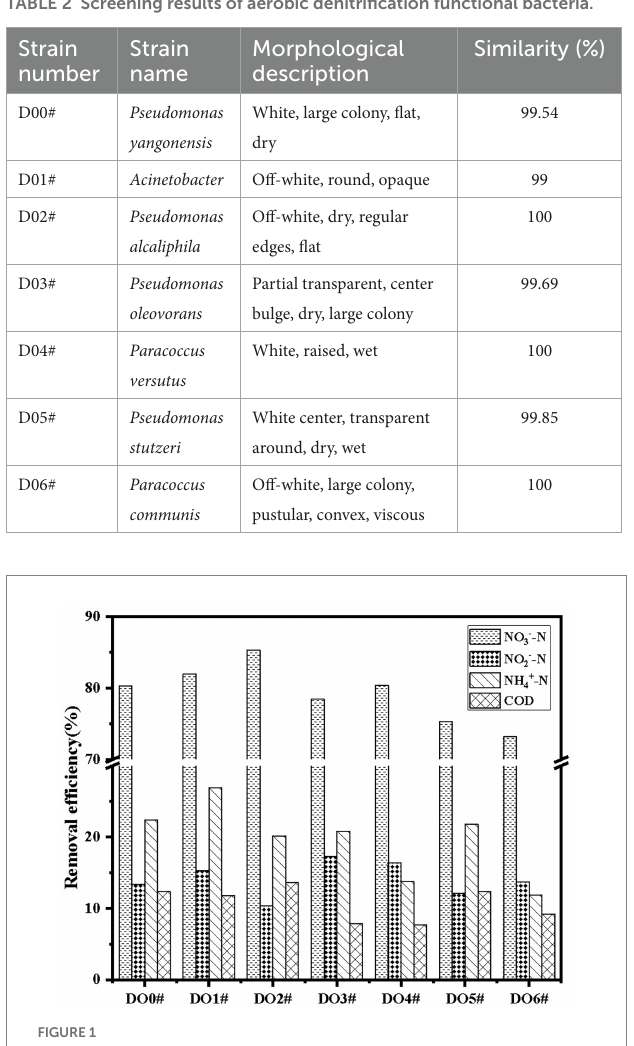
FIGURE 1 Performance of dominant